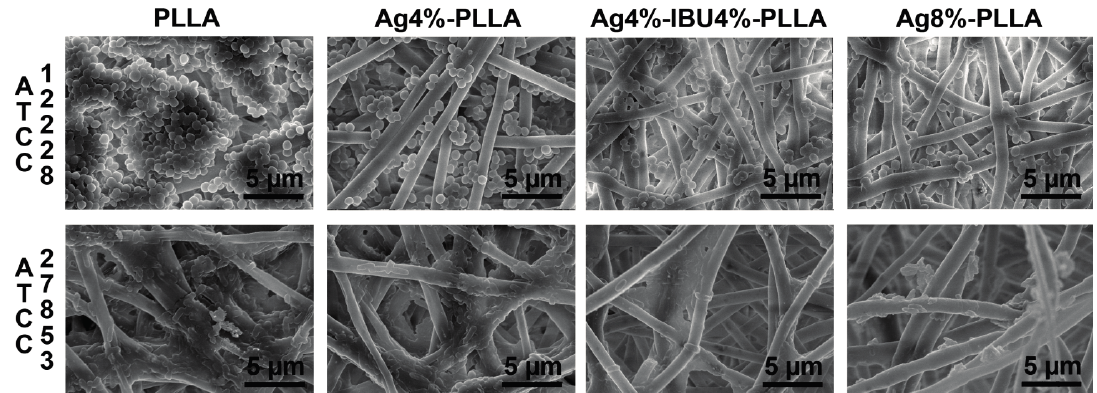
Figure 6. The SEM images of bacteria on the surface of different electrospun fibers after 1 day